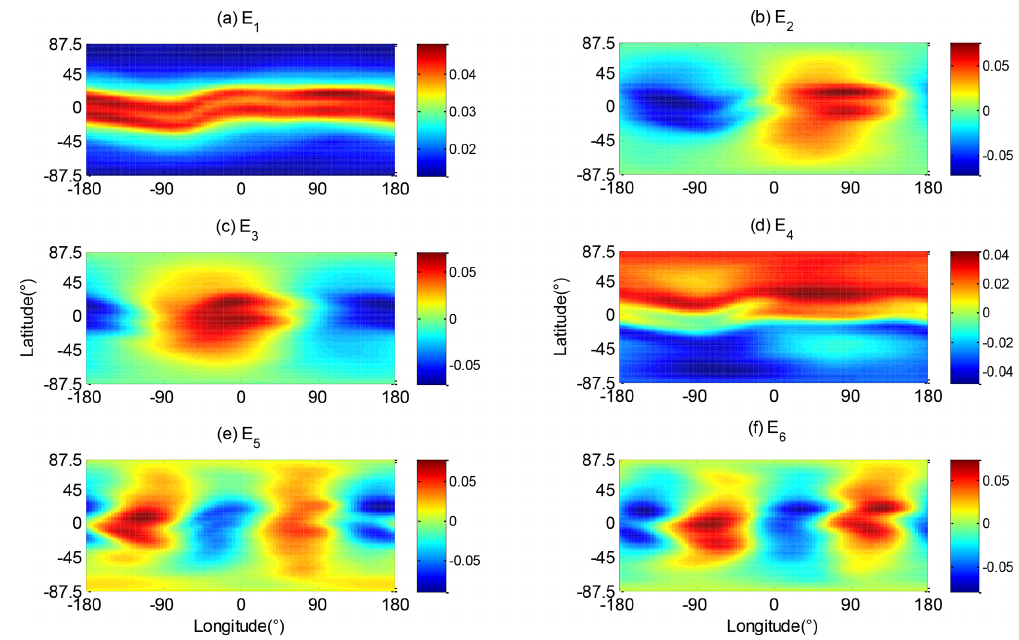
Figure 8. Six EOF base functions E 1 – E 6 extracted in accordance with Eq.